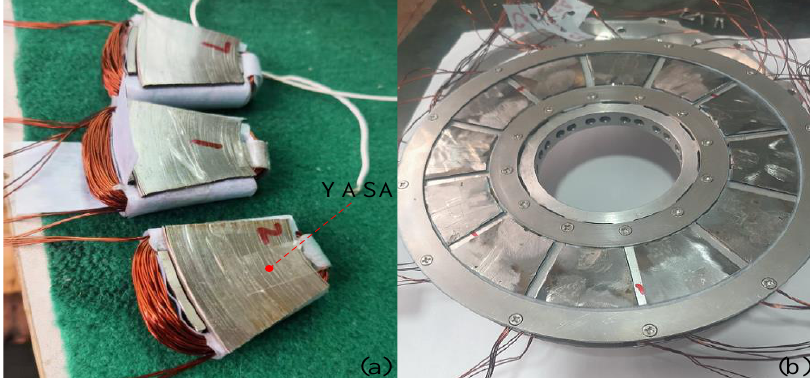
Figure 23. Stator component ( a ) single iron with coil, ( b ) stator.